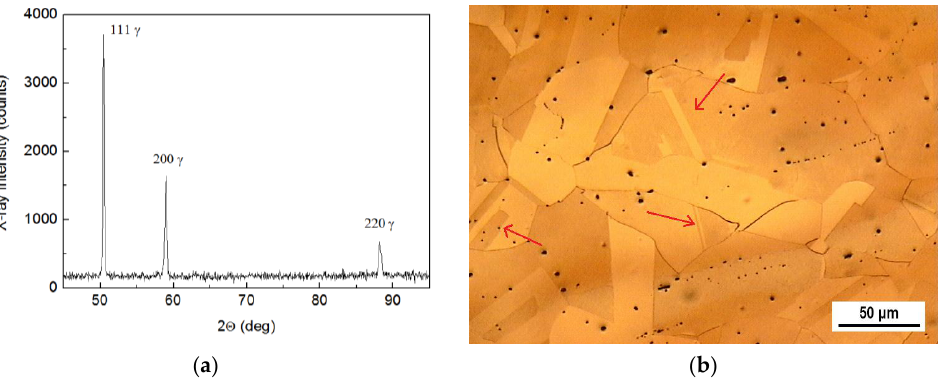
Figure 1. ( a ) XRD spectrum of the as-prepared material. ( b ) Microstructure of the steel.